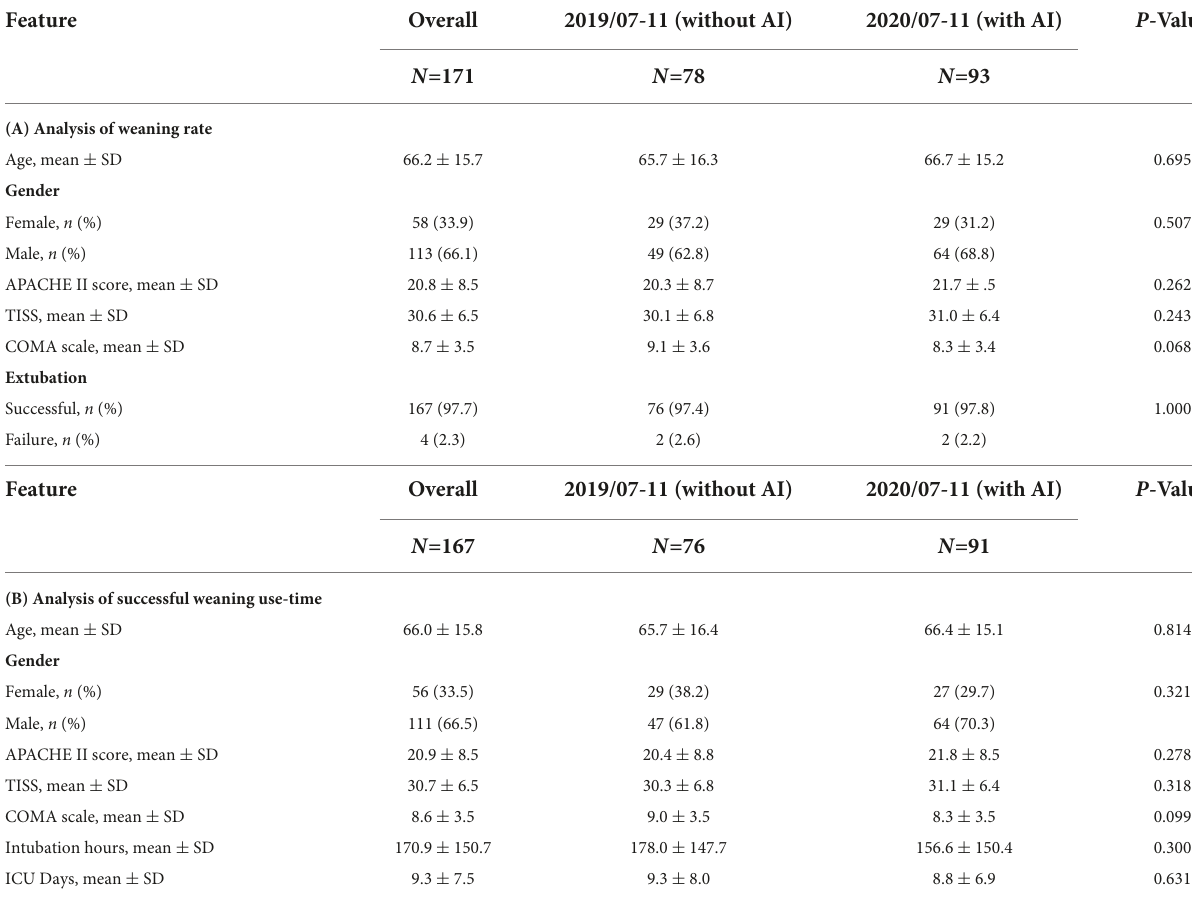
TABLE 4 The results of clinical evaluation and comparison.